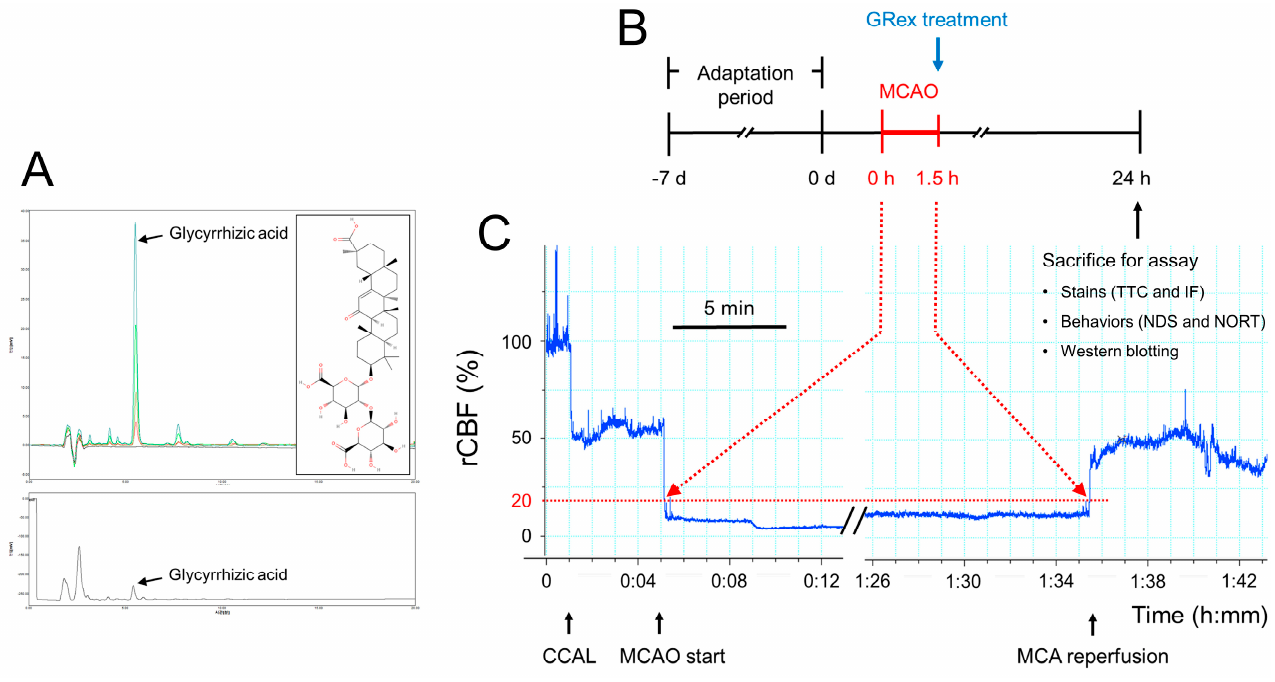
Figure 1. High - performance liquid chromatography (HPLC) analysis and experimental design for middle cerebral artery occlusion (MCAO) mice model: ( A ) HPLC chromatogram of the glycyrrhizic acid standards and its chemical structure (upper panel) and the methanolic extract of GR (GRex) (lower panel); conditions used: HPLC, YL - 9100 system; column, ZORBAX Eclipse XBD - C18; mobile phase, a mixture of acetonitrile and 1% acetic acid in water (40:60, v / v ); wavelength, 254 nm; column temperature, 25 °C; flow rate, 1.0 mL/min; injection volume, 10 μ L; ( B , C ) ischemic stroke model in mice; mice were adapted for seven days at animal facilities. The MCAO was maintained for 90 min, and it was confirmed that relative cerebral blood flow (rCBF) was continuously maintained under 20%. After MCAO, GRex was administered, and biological indicators of experimental animals were measured at 22.5 h after reperfusion; CCAL, common carotid artery ligation.